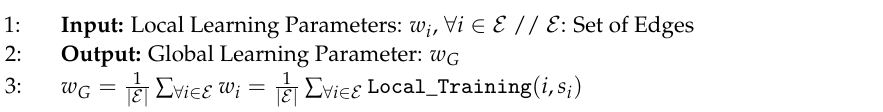
Algorithm 2 Fair Federated Learning Computation at a Central